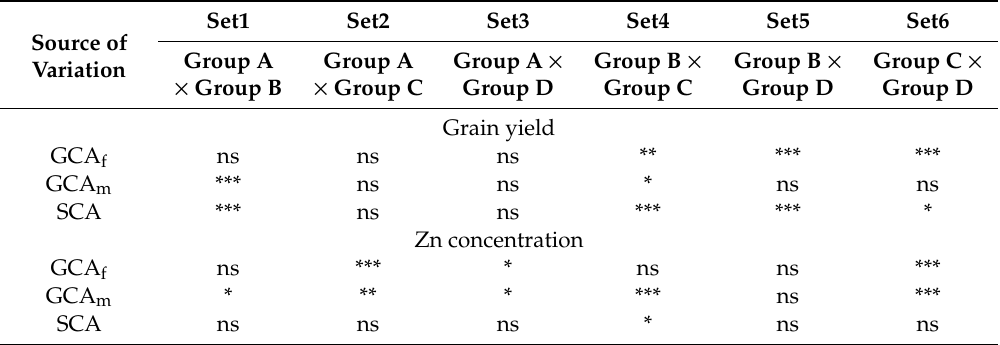
Table 5. Analysis of variance of general combining ability (GCA) and specific combining ability (SCA) e ff ects for grain yield and Zn concentration. Source of